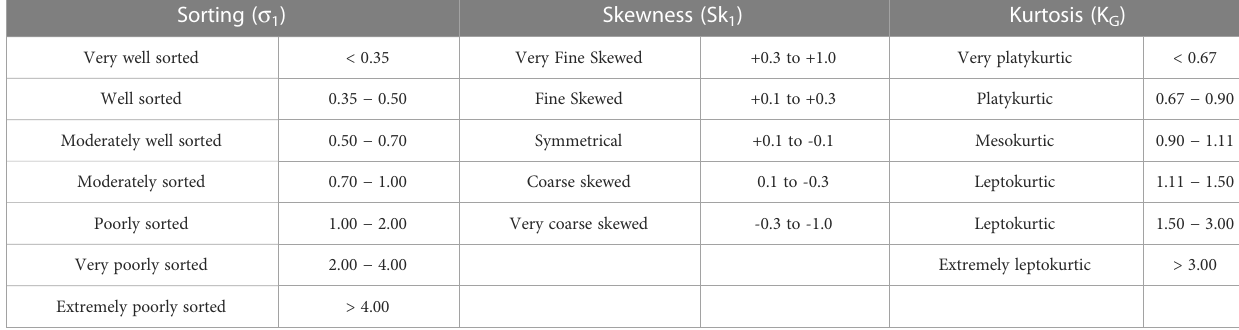
TABLE 1 Descriptive expressions for different categories of sorting, skewness and kurtosis (Blott and Pye, 2001). Sorting ( s 1